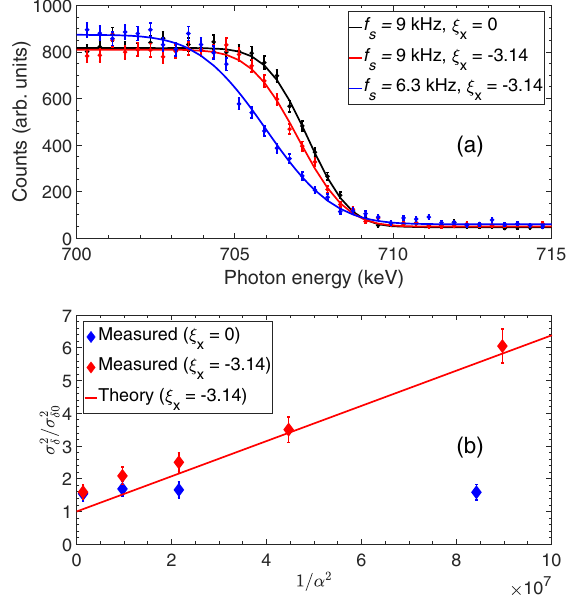
FIG. 1. Measurement of the electron beam energy widening brought by the horizontal chromaticity using the CBS method. (a) The cutoff edges of CBS photon spectra under different ξ x and f α ). (b) Quantitative evaluation of the cut-off edges s (therefore revealing the energy spread and its comparison with theory Eq. (6). The error bars in both figures are the one sigma uncertainties of the measurements and are due to calibration errors and counting statistics. The data acquisition of each spectrum takes 15